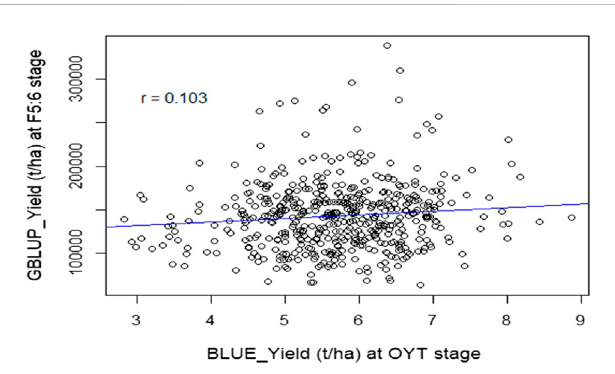
FIGURE 5 Scatter plot of gBLUP for the yield of F 5:6 lines against the corresponding BLUE values estimated from yield testing in OYT during the Boro season of 2022. The value “ r ” indicates the accuracy of the prediction.